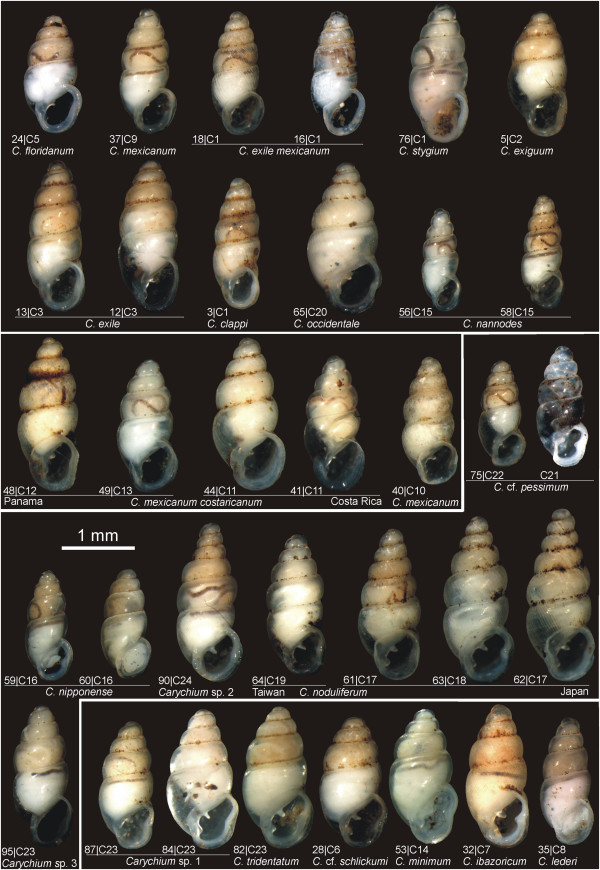
Carychium morphospecies and corresponding genetic lineages. Traditionally identified morphospecies and their respective delimitated evolutionary lineage (C1-C25) and specimen identifier are visualized. The lineage C21 (C. cf. pessimum) is figured by an empty shell of the same population instead of an analyzed individual.